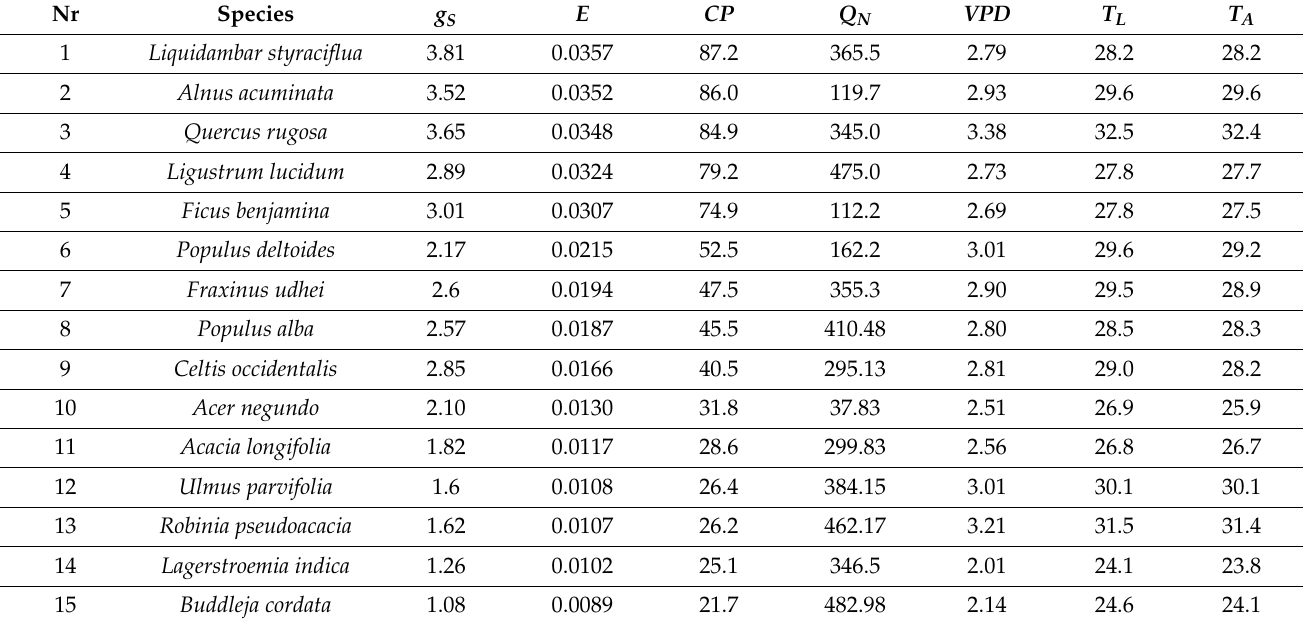
Table 2. Averages of stomatal conductance ( g S , cm s − 1 ) transpiration ( E , g m − 2 s − 1 ), cooling